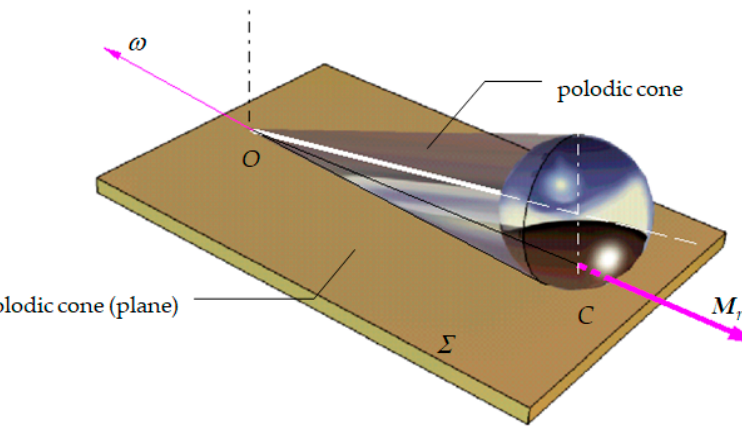
Figure 4. Conical pendulum.